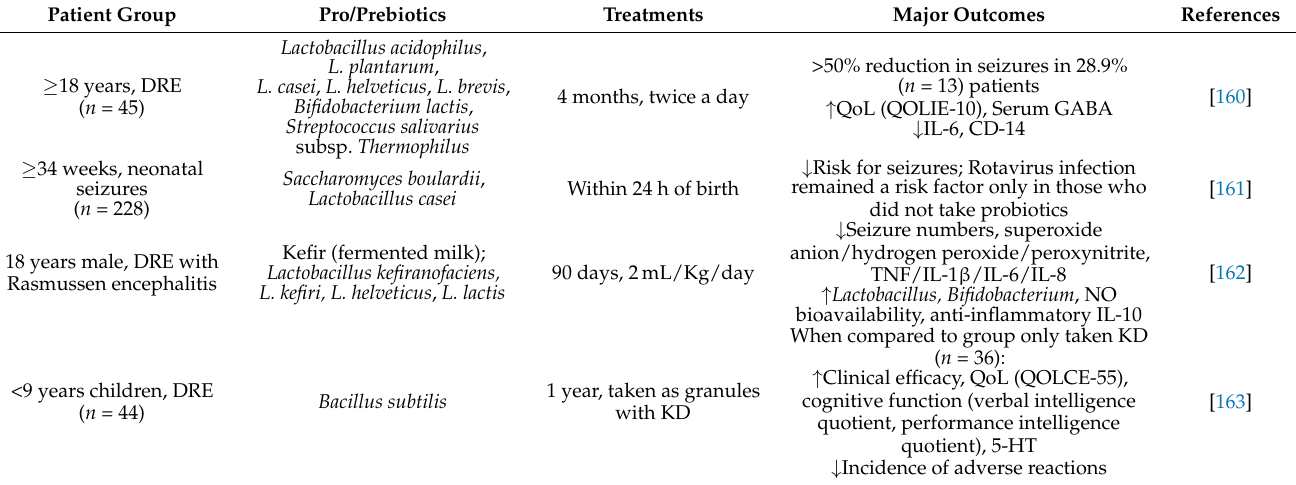
Table 4. Clinical trials on the effects of pro/prebiotics on epilepsy, in published order. Patient